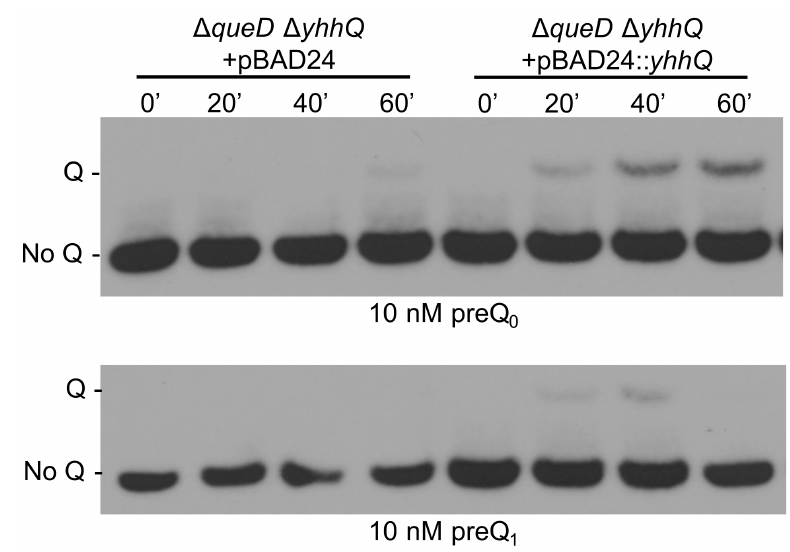
Figure 4. The role of YhhQ as involved in Q precursors salvage is validated by complementation of the Δ queD Δ yhhQ . Test of the salvage capability of the Δ queD Δ yhhQ grown in M9 + 0.5% glycerol strains carrying the empty plasmid pBAD24 or pBAD24:: yhhQ induced with 0.2% arabinose. Representative Northern blots shown.